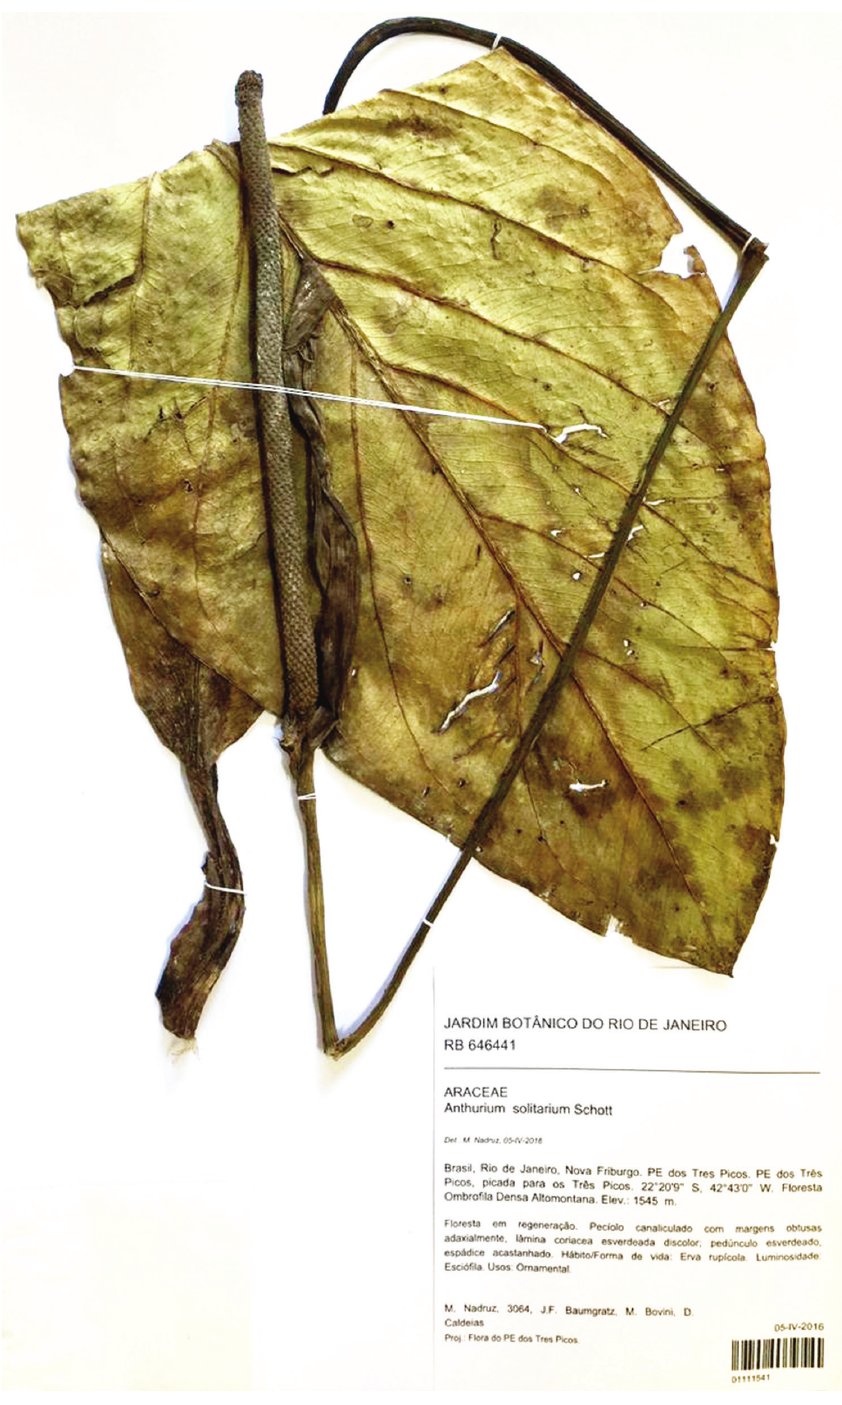
Figure 4. Epitype of Anthurium solitarium ( ≡ Pothos solitarius ) in RB herbarium